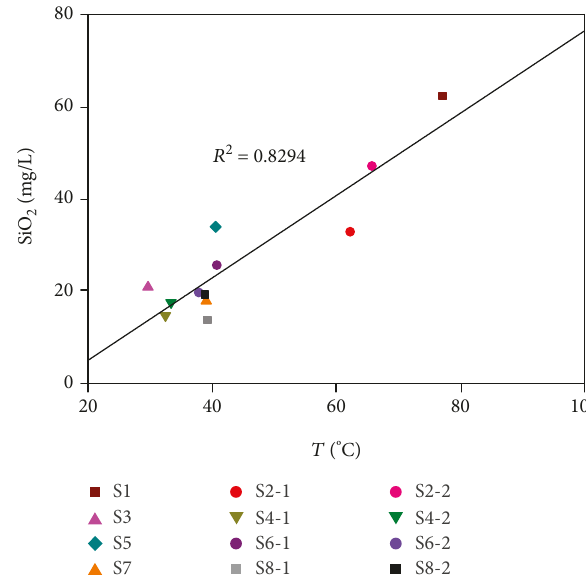
Figure 8: Relationship between SiO samples in the Simao